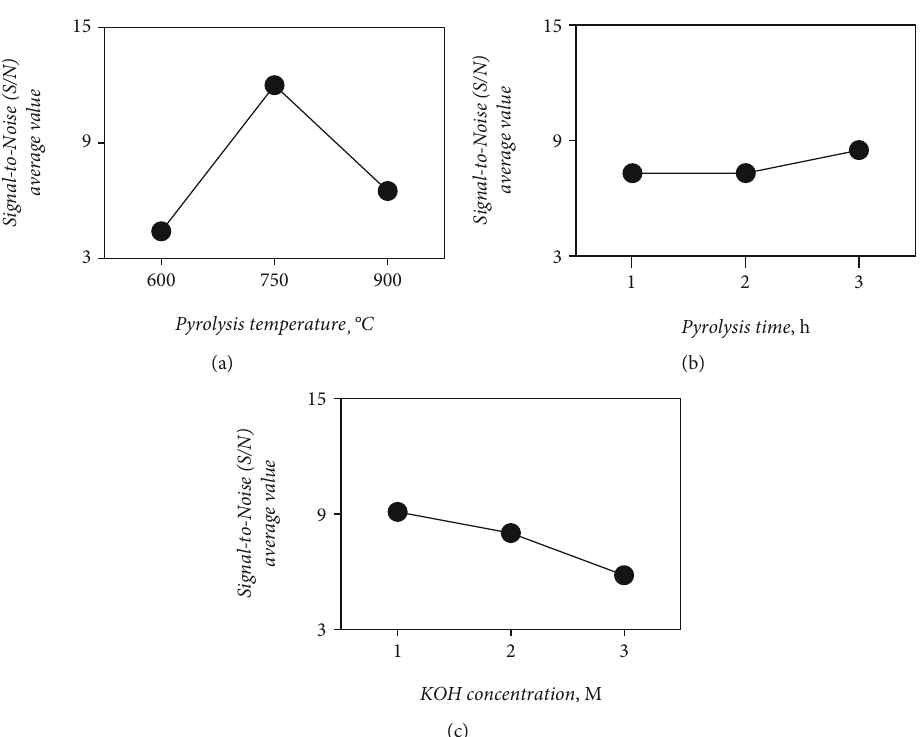
Figure 4: S/N analysis of the Taguchi experimental design used in the preparation of CSK for itaconic acid separation from the aqueous